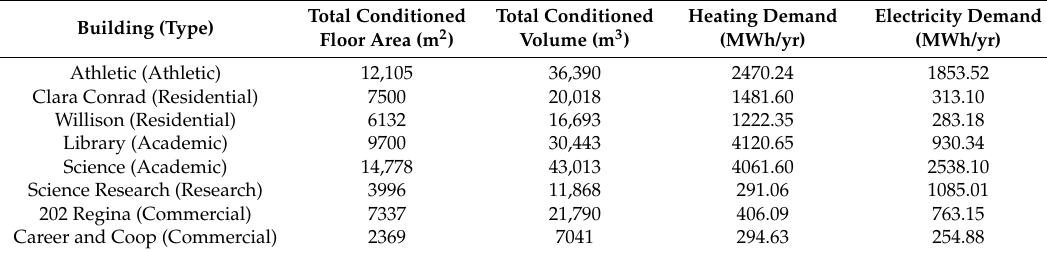
Figure 4 . Map of Laurier campus. Only the highlighted buildings were considered in the case study [36]. Table 1 . Summary of building characteristics and energy consumption loads of buildings considered in the case study.